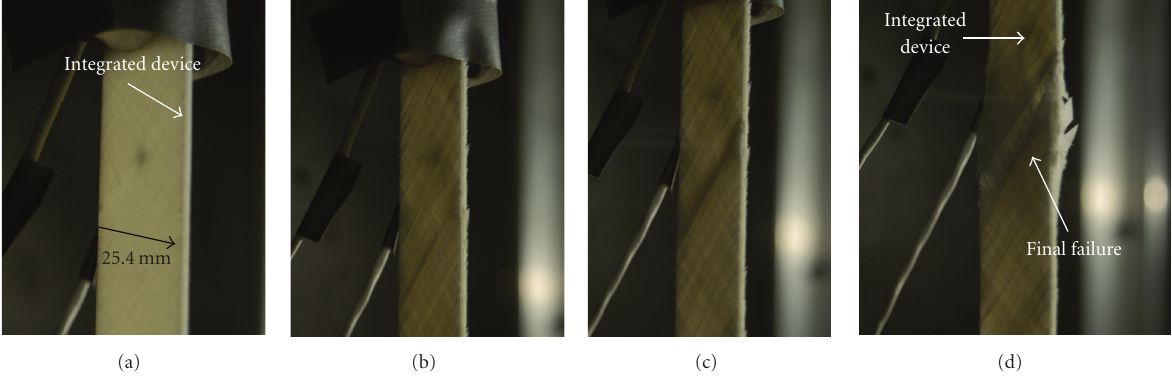
Figure 11: Typical failure mode of [( ± 45)